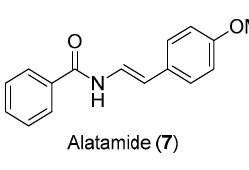
Figure 3. Molecular structure of alatamide.